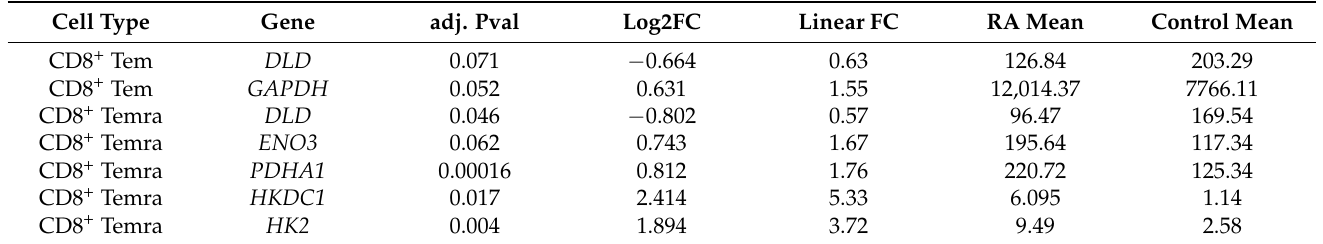
Table 6. Glycolysis/gluconeogenesis pathway DEGs in untreated RA T cell subsets. Means are calculated from DESeq2 normalized counts.